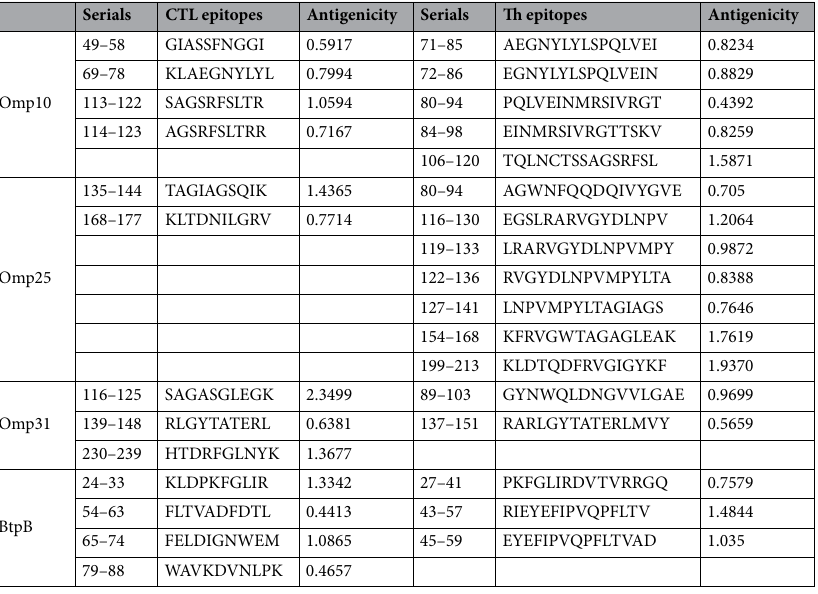
Table 1. List of the final selected CTL and HTL